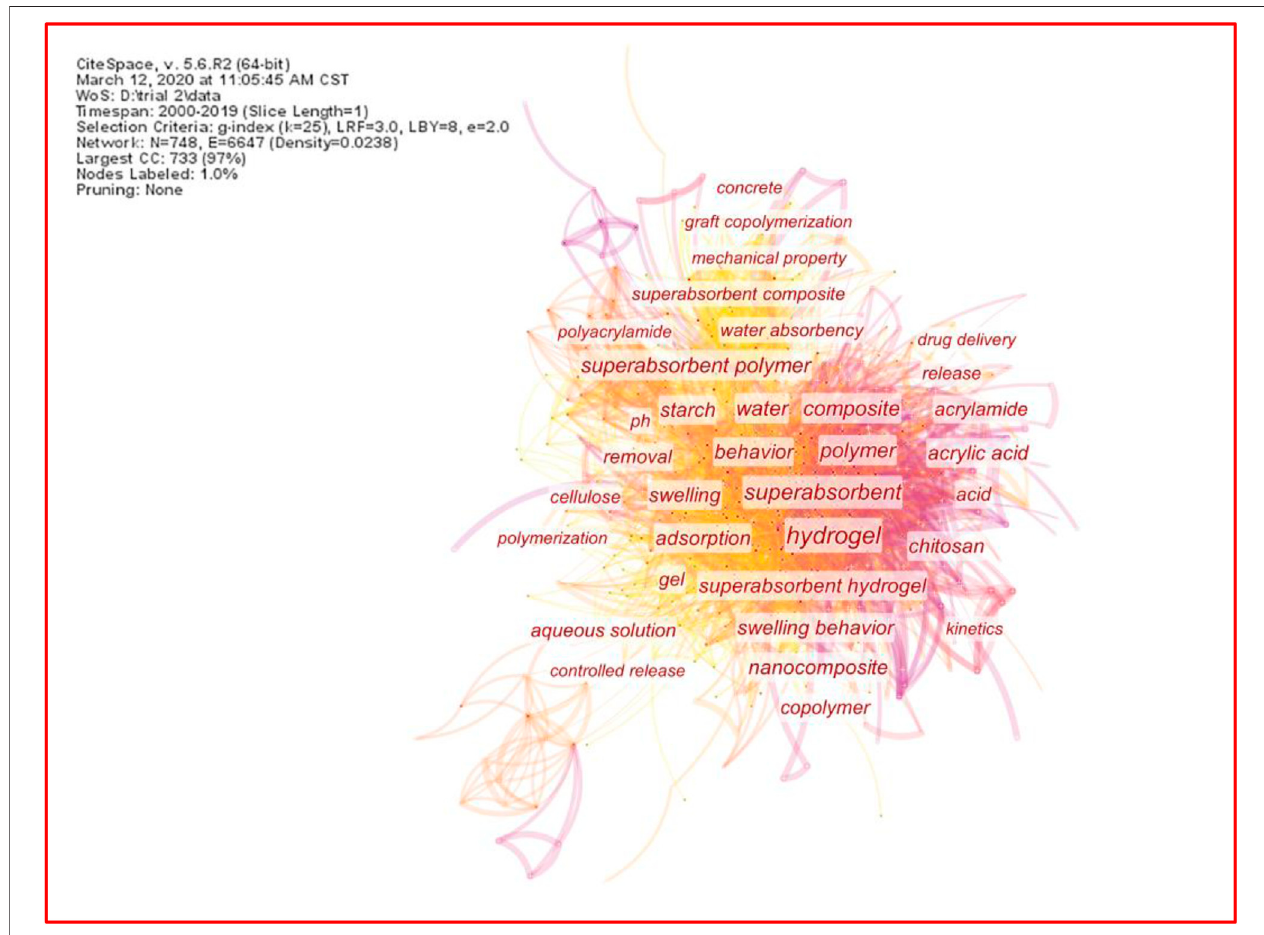
FIGURE 3 | Co-occurring keyword network of superabsorbents (frequency > 100) in 2000 – 2019 from CiteSpace.